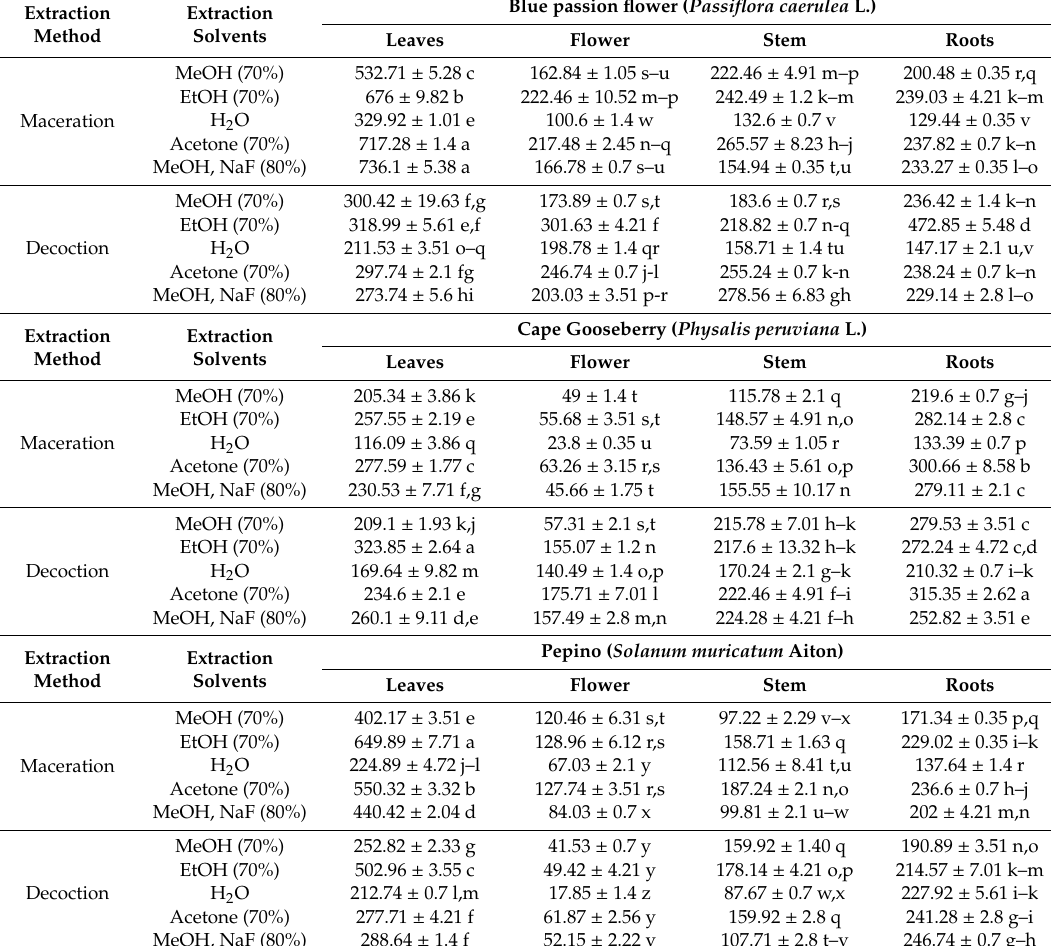
Table 3. Flavonoid content (mg eq Qu / 100 g DM) in the di ff erent parts of blue passion flower ( Passiflora caerulea L.), cape gooseberry ( Physalis peruviana L.) and pepino ( Solanum muricatum Aiton) extracted by decoction and